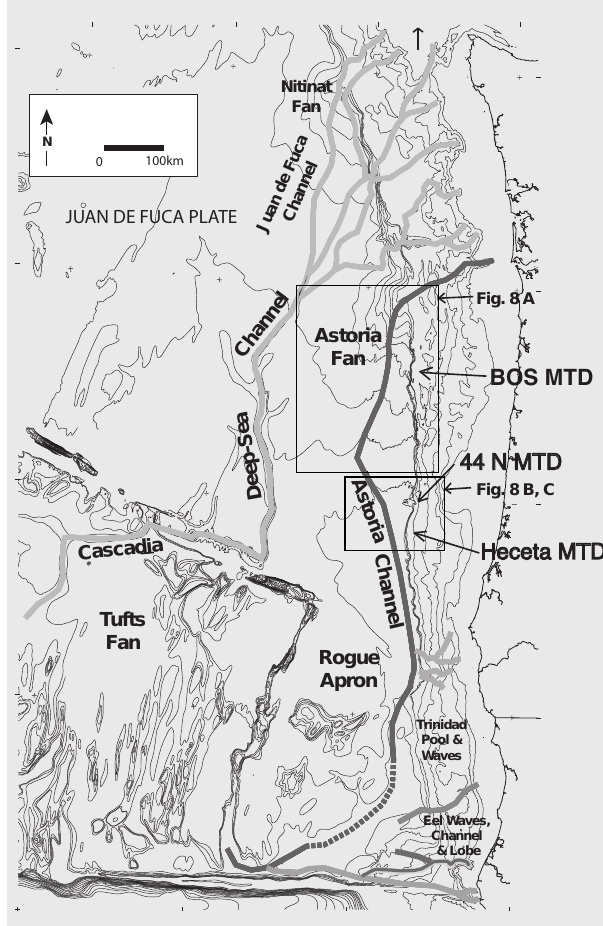
Fig. 3. Bathymetric map showing location and setting of the BOS, Heceta, and 44 N MTDs and the different types of turbidite systems in Cascadia Basin. Nitinat and Astoria are submarine fans; Cascadia Channel is a deep-sea channel following a tectonic lineament, and Rogue Apron is a non-channelized base-of-slope apron with sheet turbidites. The Trinidad and Eel are plunge pool and sediment wave turbidite systems. The locations of Fig. 8a and b are outlined with boxes. (Figure is modified from Nelson at al.,